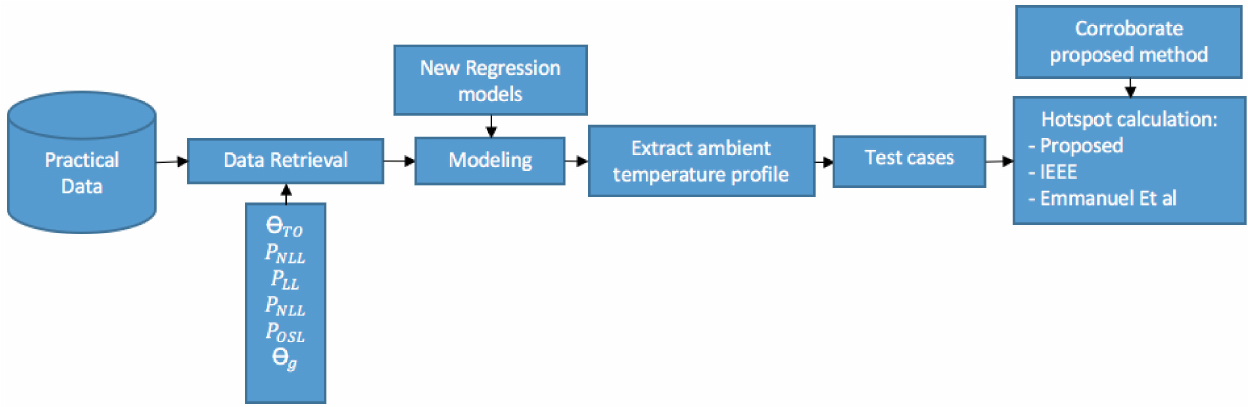
Figure 5. Method flow